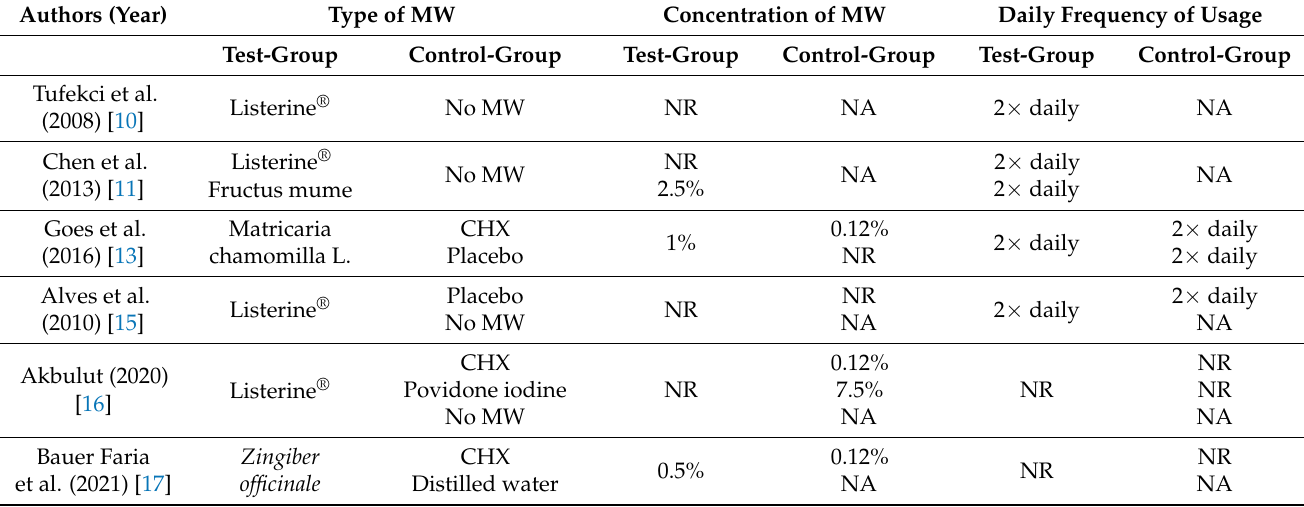
Table 3. Type, concentration and daily frequency of mouthwash